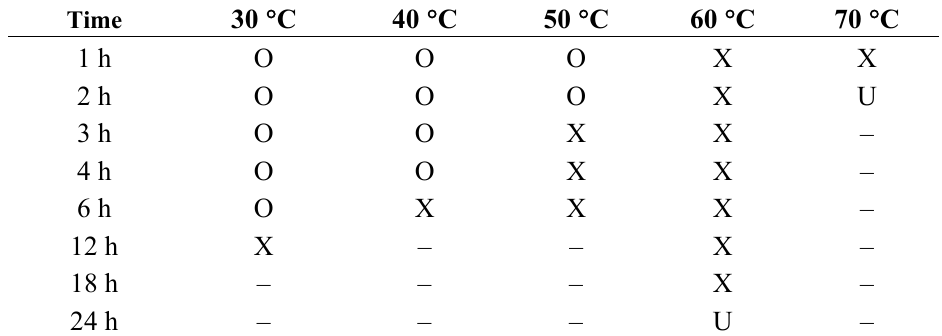
Table 2. Solubility of SPEEK produced at various sulfonation temperatures and reaction